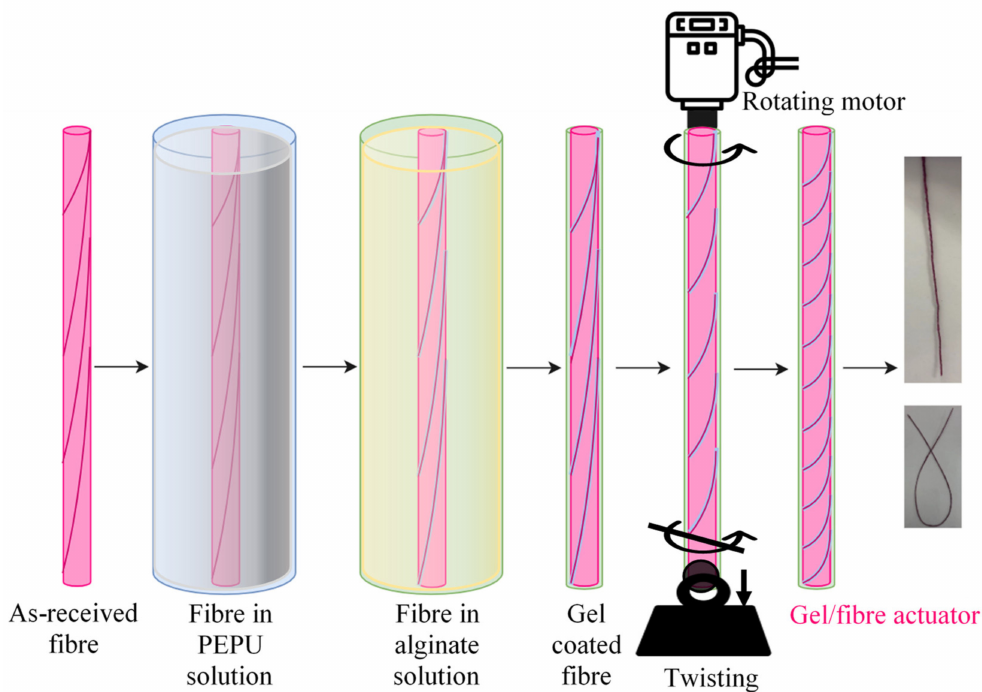
Figure 1. Schematic illustration of fabricating twisted gel/fibre torsional